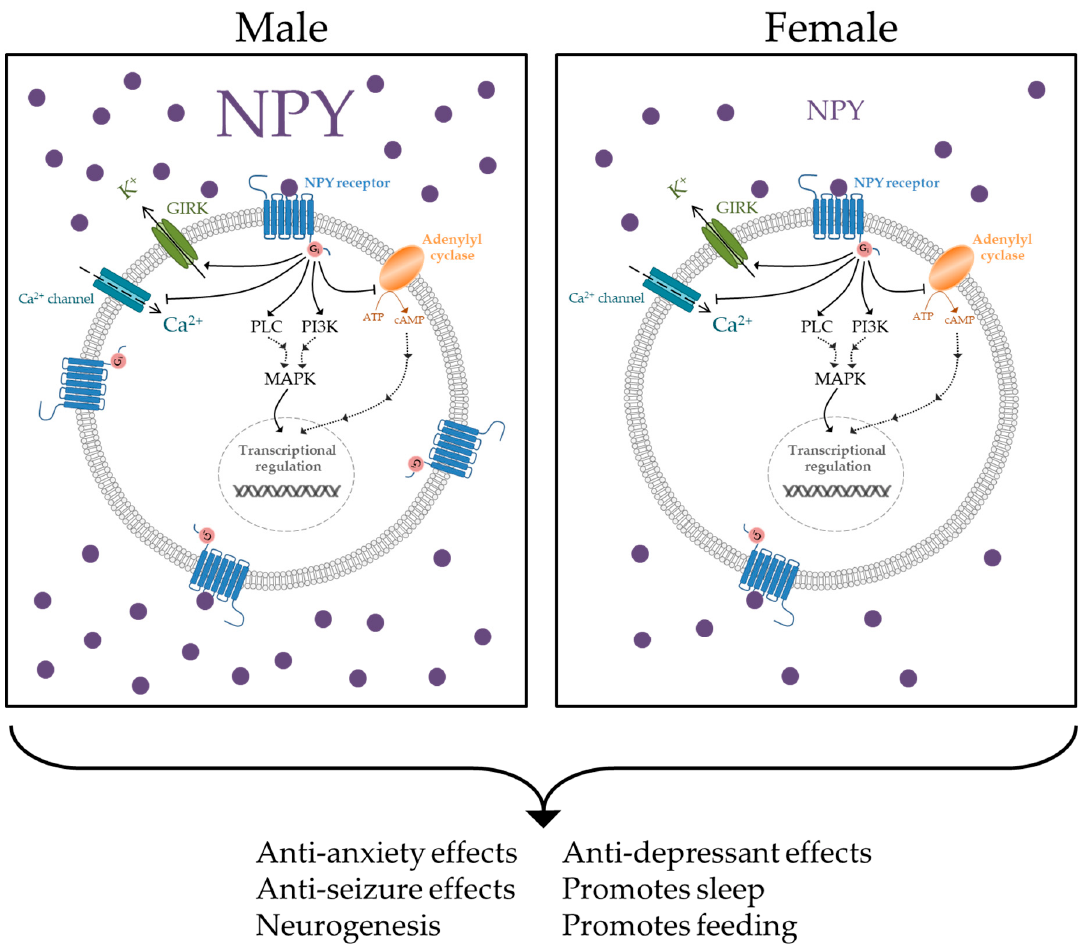
Figure 1. Neuropeptide Y (NPY) downstream signaling e ff ects include inactivation of adenylyl cyclase and calcium channels, as well as activation of G protein-coupled inwardly-rectifying potassium (GIRK) channels, phospholipase C (PLC), and phosphoinositide 3-kinase (PI3K) [22,25]. The NPY system promotes numerous beneficial functions [57–63]. Females demonstrate less NPY peptide and